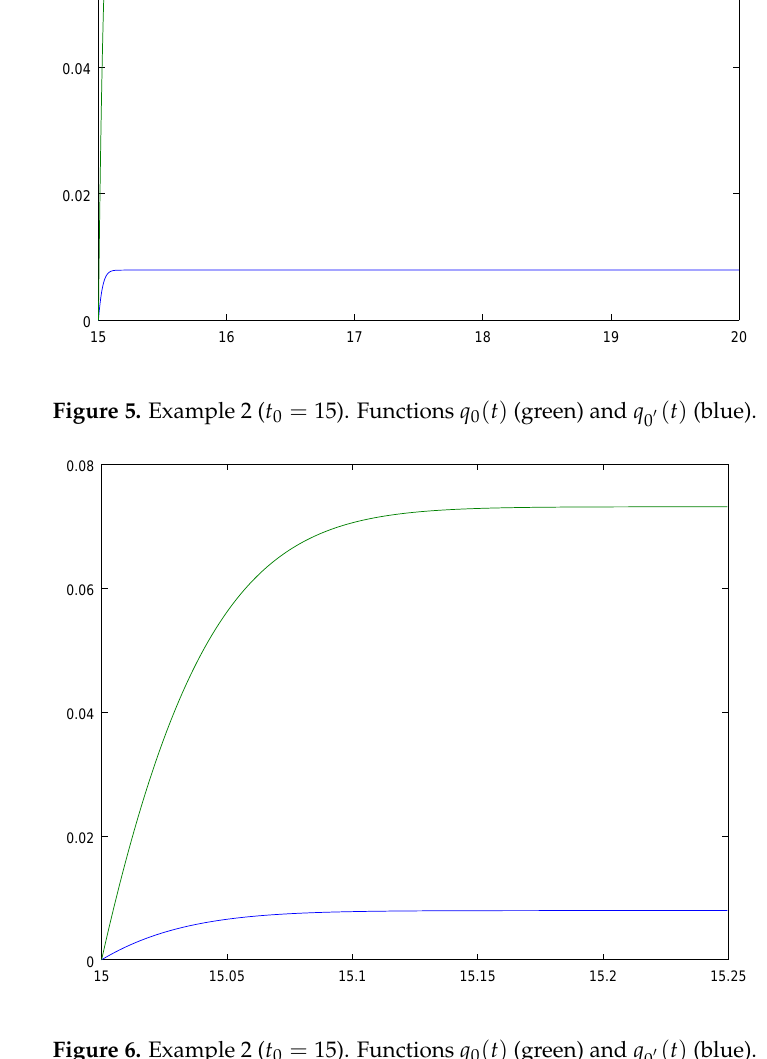
Figure 6. Example 2 ( t 0 = 15). Functions q 0 ( t ) (green) and q 3. Put now t 0 = 15.1 and compute the corresponding solution of system Equation (3) in the interval [ 15.1, 20.1